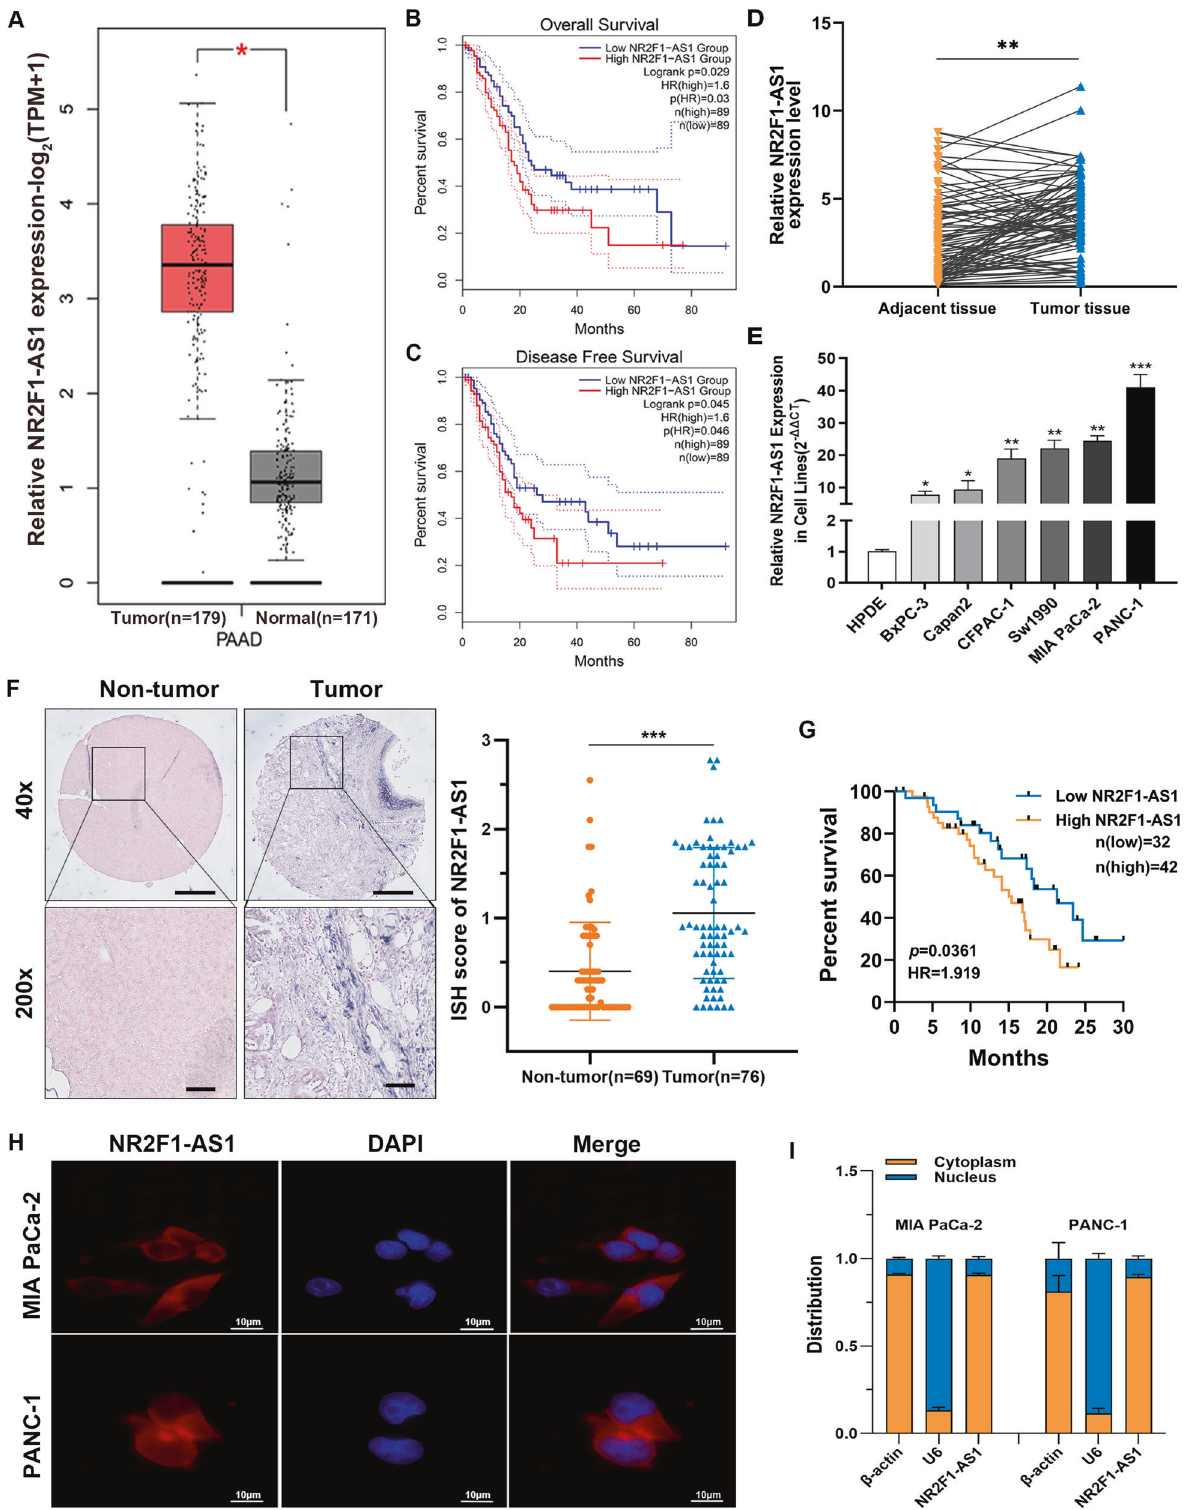
features of PC patients. Kaplan – Meier curves and the log-rank test were used to analyze overall survival rates. Pearson ’ s correlation analysis was adopted for correlation analysis between genes. Student ’ s t test or one- way ANOVA were used for statistical comparisons between